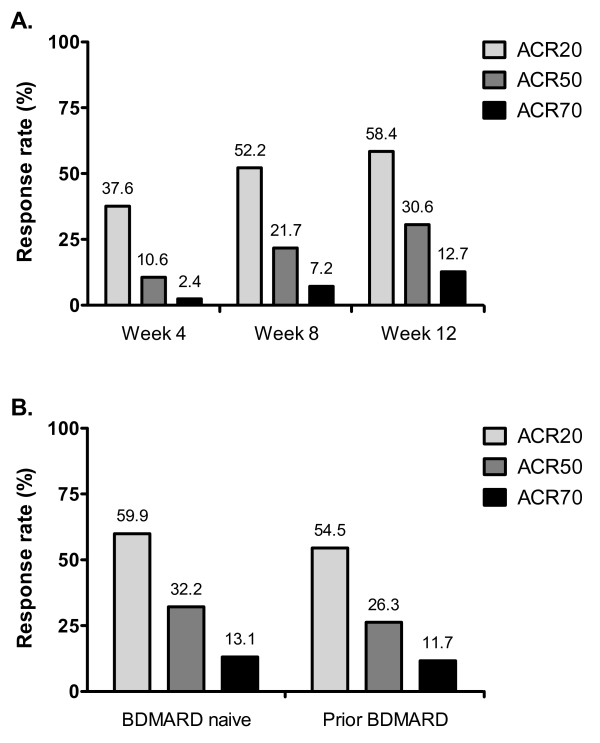
Response in American College of Rheumatology (ACR) Criteria Following Adalimumab Treatment. Percentages of patients who met the AC R criteria for 20%, 50%, and 70% improvement (ACR20, ACR50, and ACR70, respectively) with adalimumab 40 mg administered subcutaneously every other week with concomitant standard antirheumatic therapy. A.) All randomized patients. B) Subgroup analysis of randomized patients on the basis of experience with biological DMARD (BDMARD) therapy.